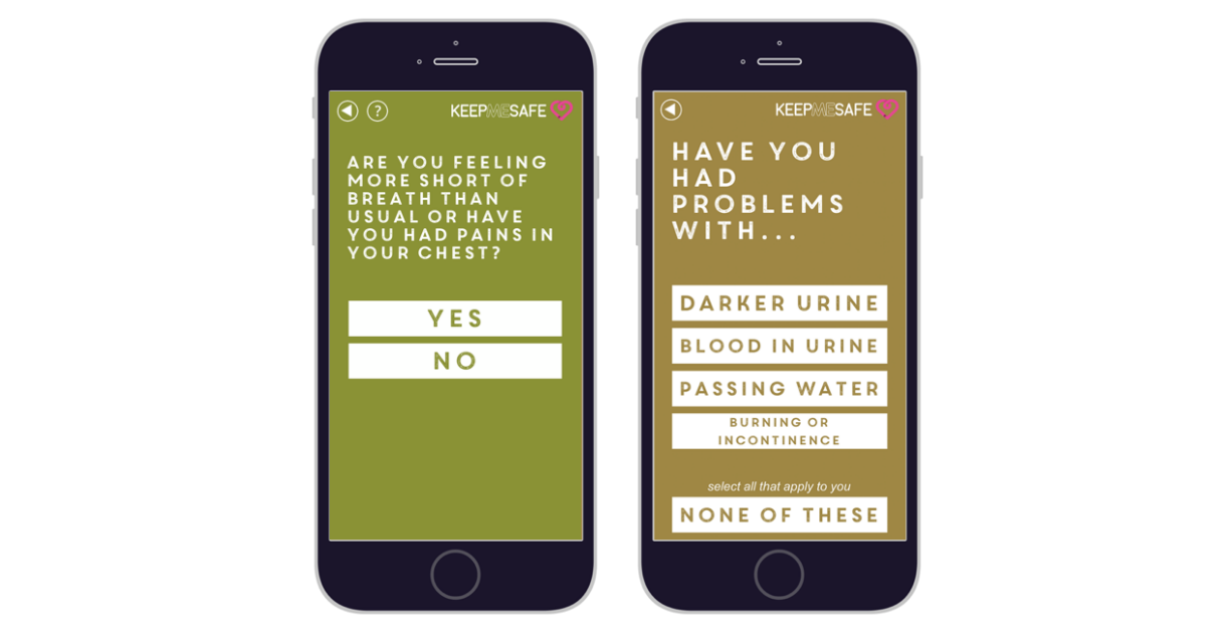
Figure 1. Sample screenshots of checklist items. Item 2 (breathlessness or chest pain) is linked to a red escalation, item 7 (urine problems) is linked to amber escalation.